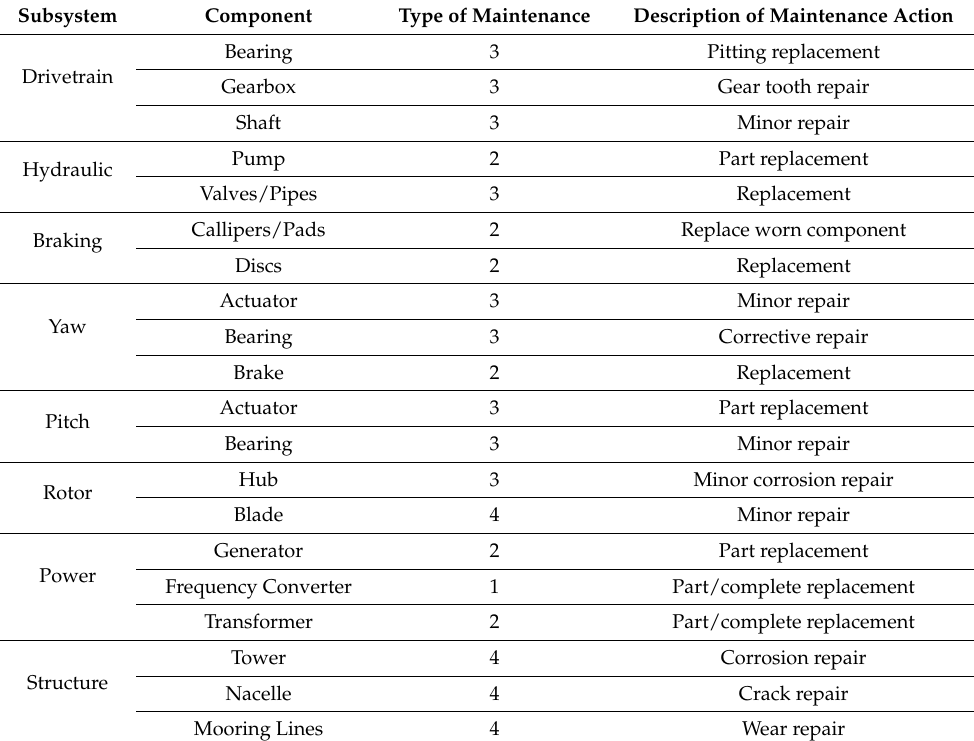
Table A1. Type of maintenance actions adopted in floating offshore wind turbines